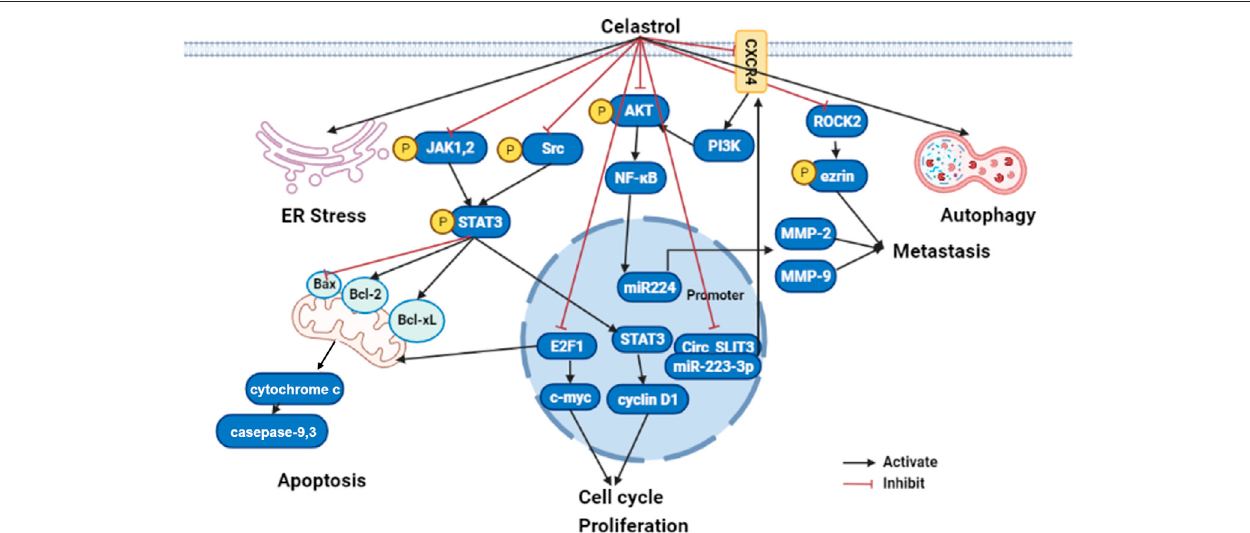
FIGURE 3 | The molecular mechanisms of celastrol in liver cancer (edited by Biorender software). Celastrol exert anticancer effect by restraining their cell growth, metastasis,andin fl ammatoryresponse,whileboostingERstress,apoptosis,andautophagydependingonmodulateddifferentsignalingpathways.Firstly,celastrolcan activate cancer cell apoptosis through inhibiting JAK2 and STAT3 phosphorylation, then downregulated BCL-2 family proteins (Bcl-2 and Bcl-xl) and upregulated caspase family proteins (caspase 3 and caspase 9). Secondly, celastrol repressed tumor cell proliferation by suppressing cyclin D1 and c-myc through E2F1 and STAT3;Lastly,celastrolprohibitedtumormetastasisbyNF- κ Bsignalingpathwaymodulated MMP-2andMMP-9throughtheCXCR4-relatedsignalingpathway, aswell as the ROCK2-mediated phosphorylation of ezrin at Thr567. ER, endoplasmic reticulum; JAK1, Janus kinase1; JAK2, Janus kinase2; STAT3, signal transducer and activator of transcription 3; Bcl-2, B-cell lymphoma-2; PI3K, phosphatidylinositol-3-kinase; AKT, protein kinase B; NF-kB, nuclear factor kappa B; MMP2, Matrix metallopeptidase 2; MMP9, Matrix metallopeptidase 9; circ_SLIT3, circRNA slit guidance ligand 3; ROCK2, Rho Associated Coiled-Coil Containing Protein kinase